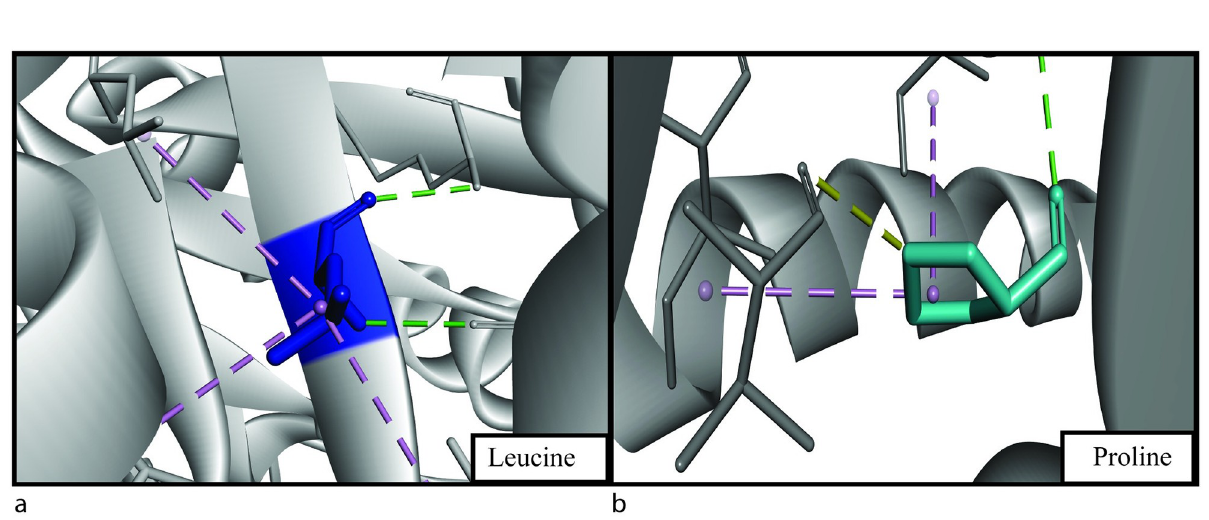
Fig 5. (a) Structural analysis showing Leu411 (blue) of native structure having 2 hydrogen bonds (green), 3 hydrophobic alkyl bonds (purple) and (b) Pro411 (turquoise) of mutant structure having a hydrogen bond (green), a carbon-hydrogen bond (yellow) and 2 alkyl hydrophobic bonds